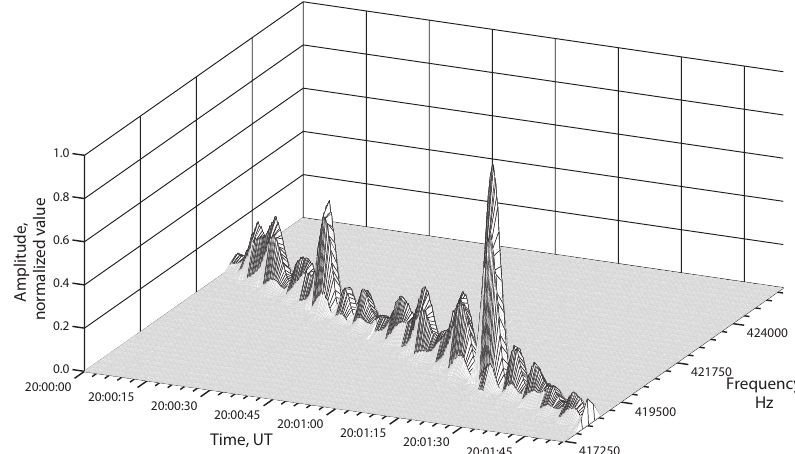
Fig.3. The amplitude of power spectrum as the function of time and frequency. Integration time: 0.25 s. Medicina, 2013 February